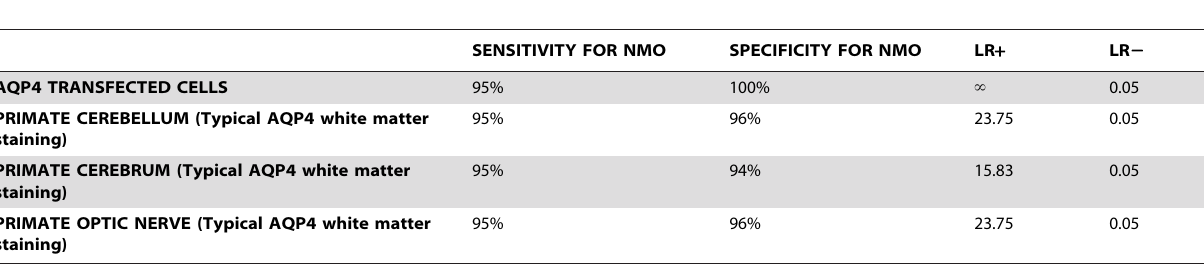
Table 3. Diagnostic sensitivity, specificity and likelihood ratios (LR + , LR 2 ) for NMO calculated for each single substrate of the BioChip, obtained by testing 91 serum samples on the ‘‘Neurology Mosaic